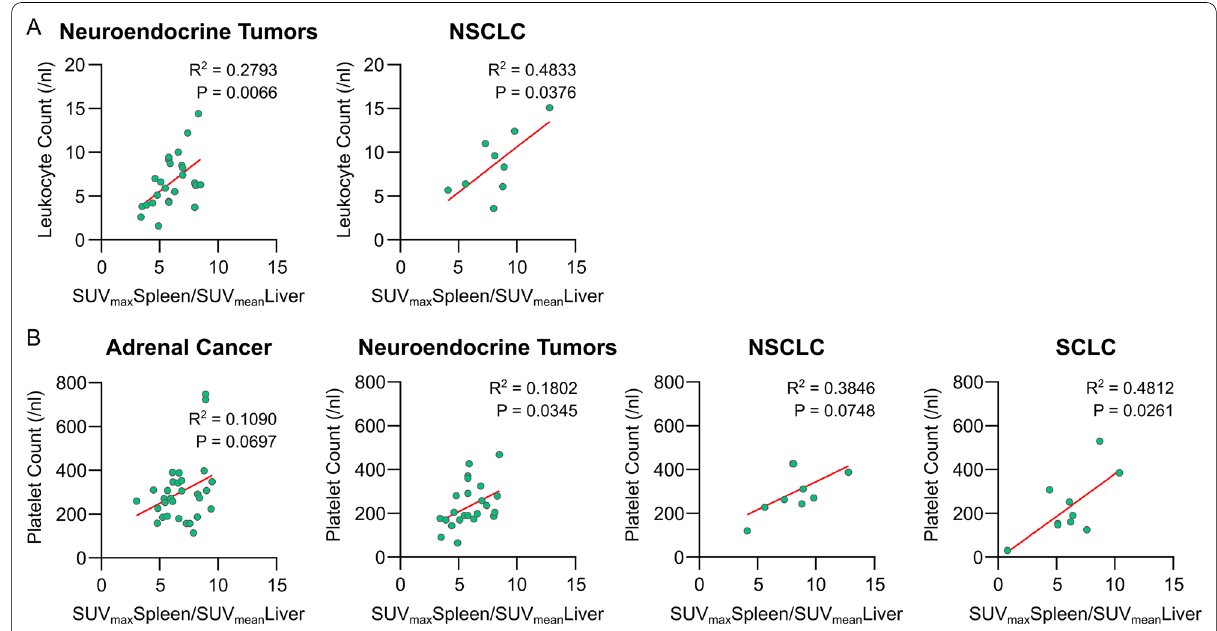
Fig. 4 Spleen [ 68 Ga]Pentixafor uptake is positively associated with peripheral blood leukocyte and/or platelet counts in neuroendocrine tumors, NSCLC and SCLC. A Correlation of spleen‑to‑liver ratio (SUV max Spleen/SUV mean Spleen) with peripheral leucocyte count in patients with neuroendocrine tumors, n 25 and NSCLC, n 9. B Correlation of spleen‑to‑liver ratio (SUV max Spleen/SUV mean Spleen) with peripheral platelet count = = in patients with adrenal tumors, n 31; neuroendocrine tumors, n 25; NSCLC, n 9 and SCLC, n 13. All statistical analyses were performed using = = = = simple linear regression. R 2 and P values as indicated on the